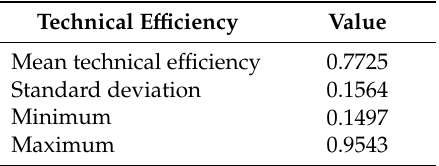
Table 4. The technical e ffi ciency estimated by the stochastic frontier analysis